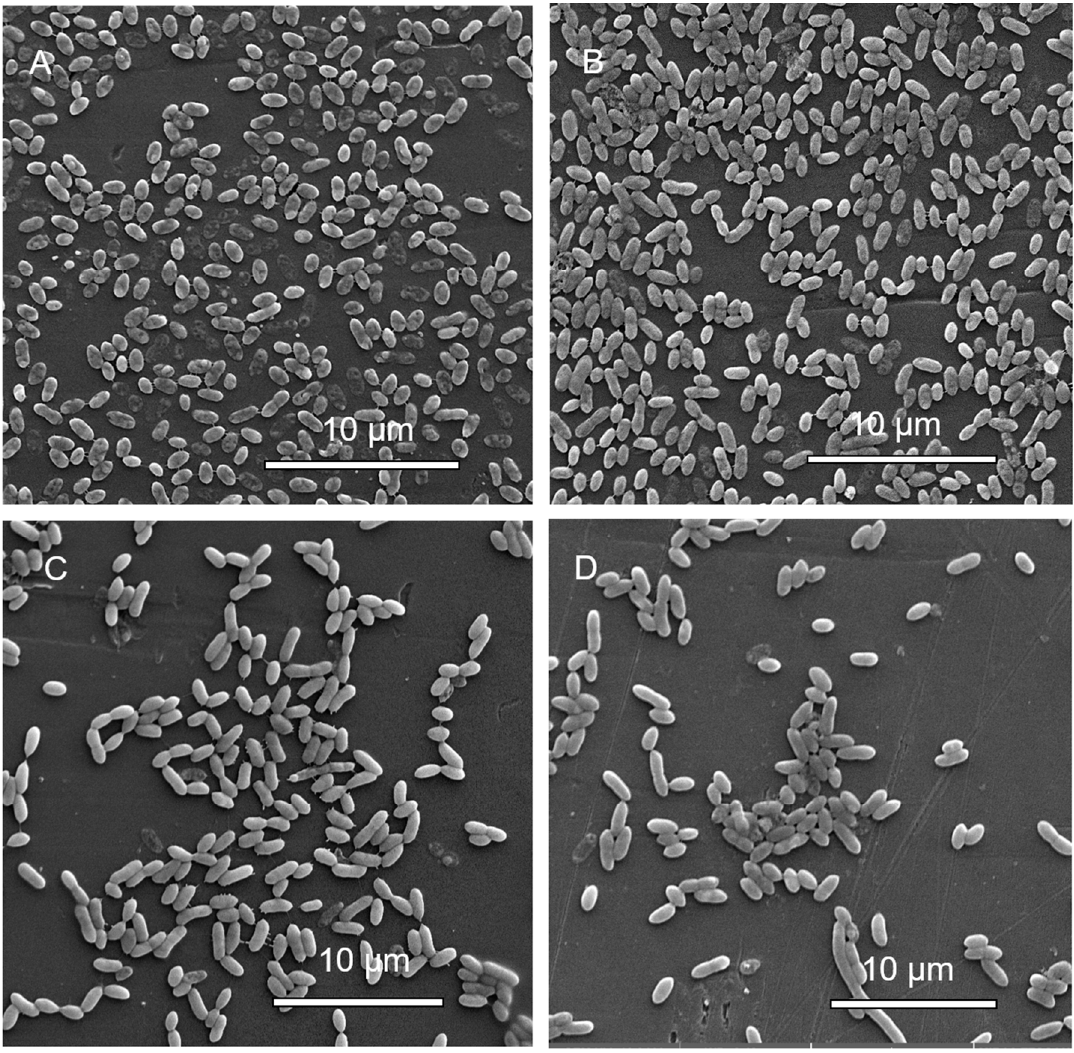
Figure 3. Scanning electron micrographs of A. hydrophila biofilm inoculation pegs at ( A ) the lowest concentration of cotrimaxazole (7.8 μ g/mL; magnified 7070×), ( B ) the highest concentration of cotrimaxazole (1000 μ g/mL; magnified 7120×), ( C ) the lowest concentration of neomycin (7.8 μ g/mL; magnified 6540×), and ( D ) the highest concentrations of neomycin (1000 μ g/mL; magnified 6470×).